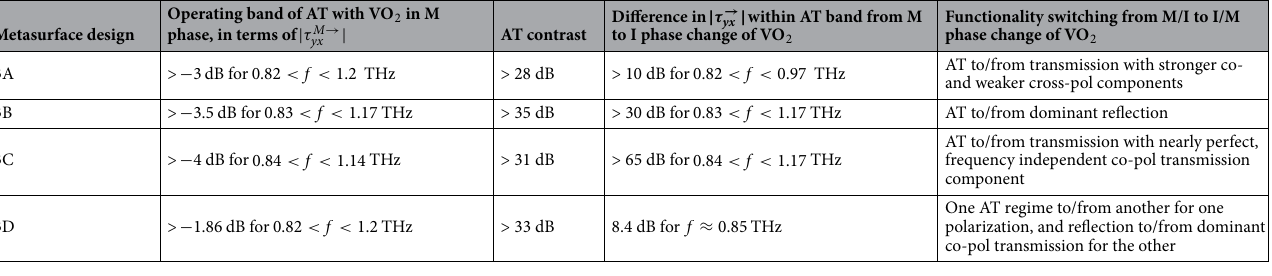
Table 1. Comparison of metasurfaces 3A-3D in terms of selected AT characteristics and the basic scenarios of functionality switching, according to Fig.